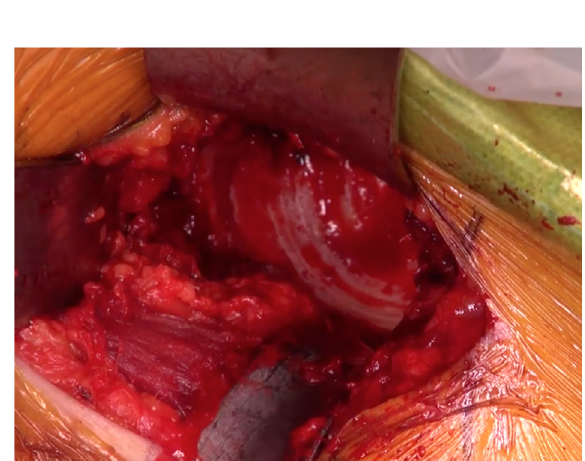
Figure 4. Two Hohmann retractors are positioned in the tear drop and on the posterior horn.